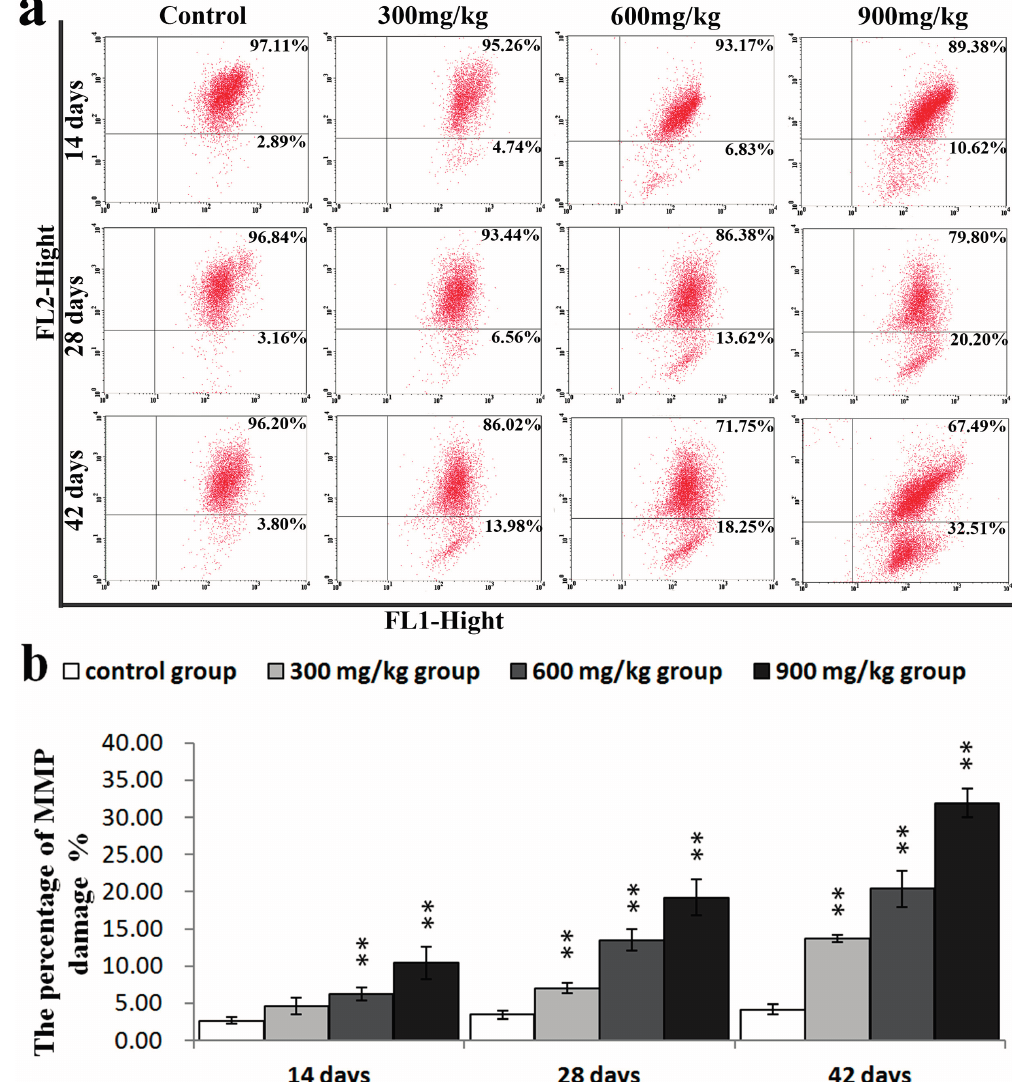
Figure 6. NiCl 2 -induced mitochondrial dysfunction in the kidney. ( a ) Representative flow cytometric diagram of MMP analysis; and ( b ) The percentage of MMP damage. Data are presented with the mean ± standard deviation ( n = 5); ** p < 0.01, compared with the control